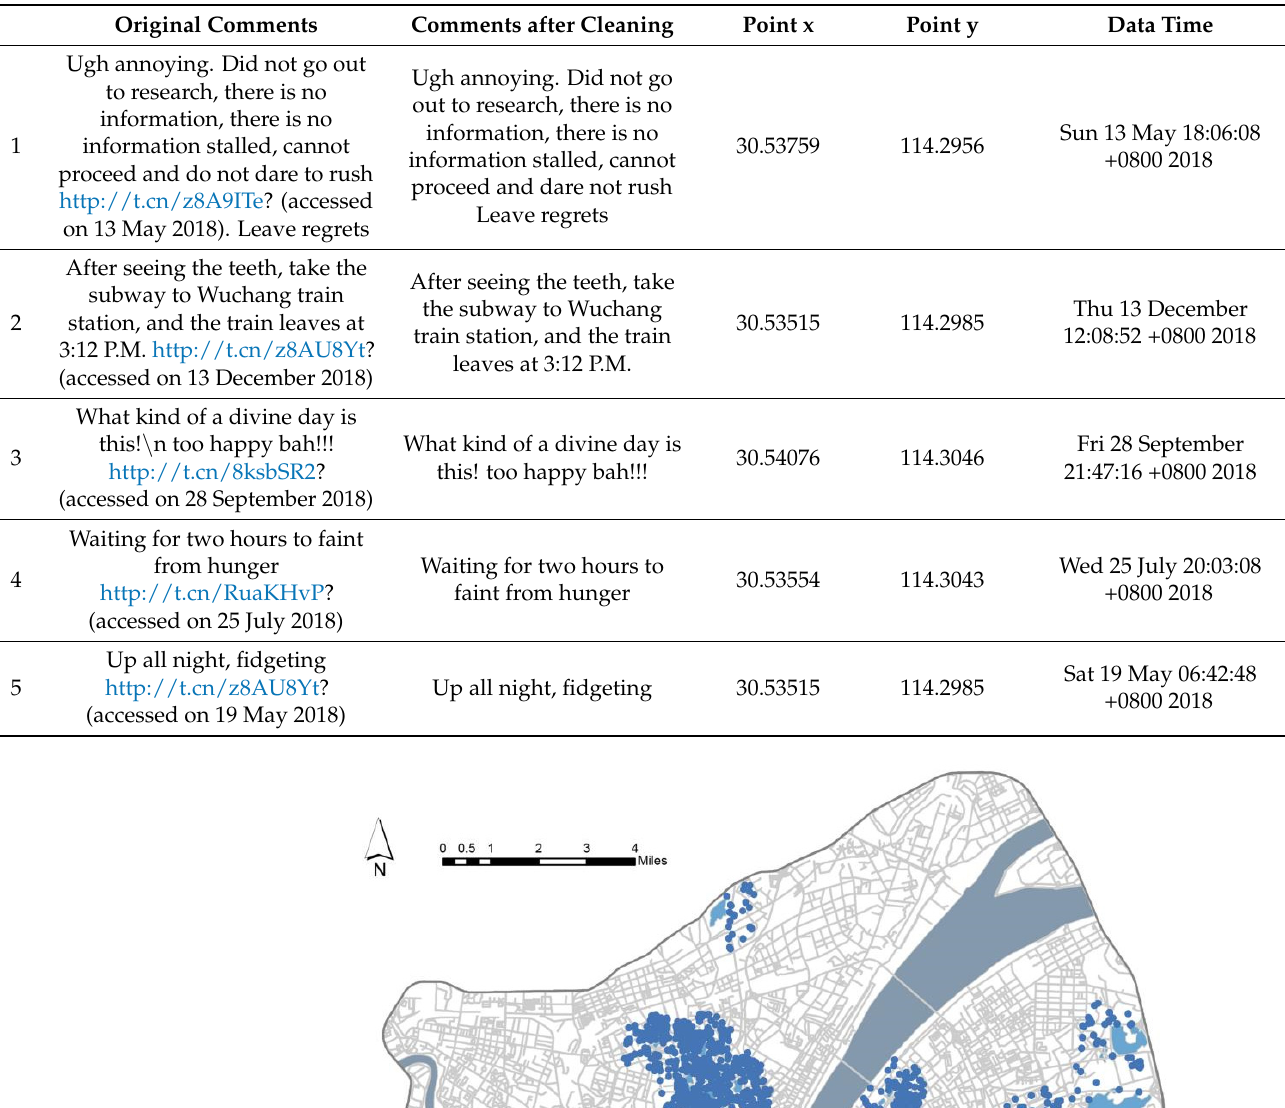
Table 2. Microblog data samples.